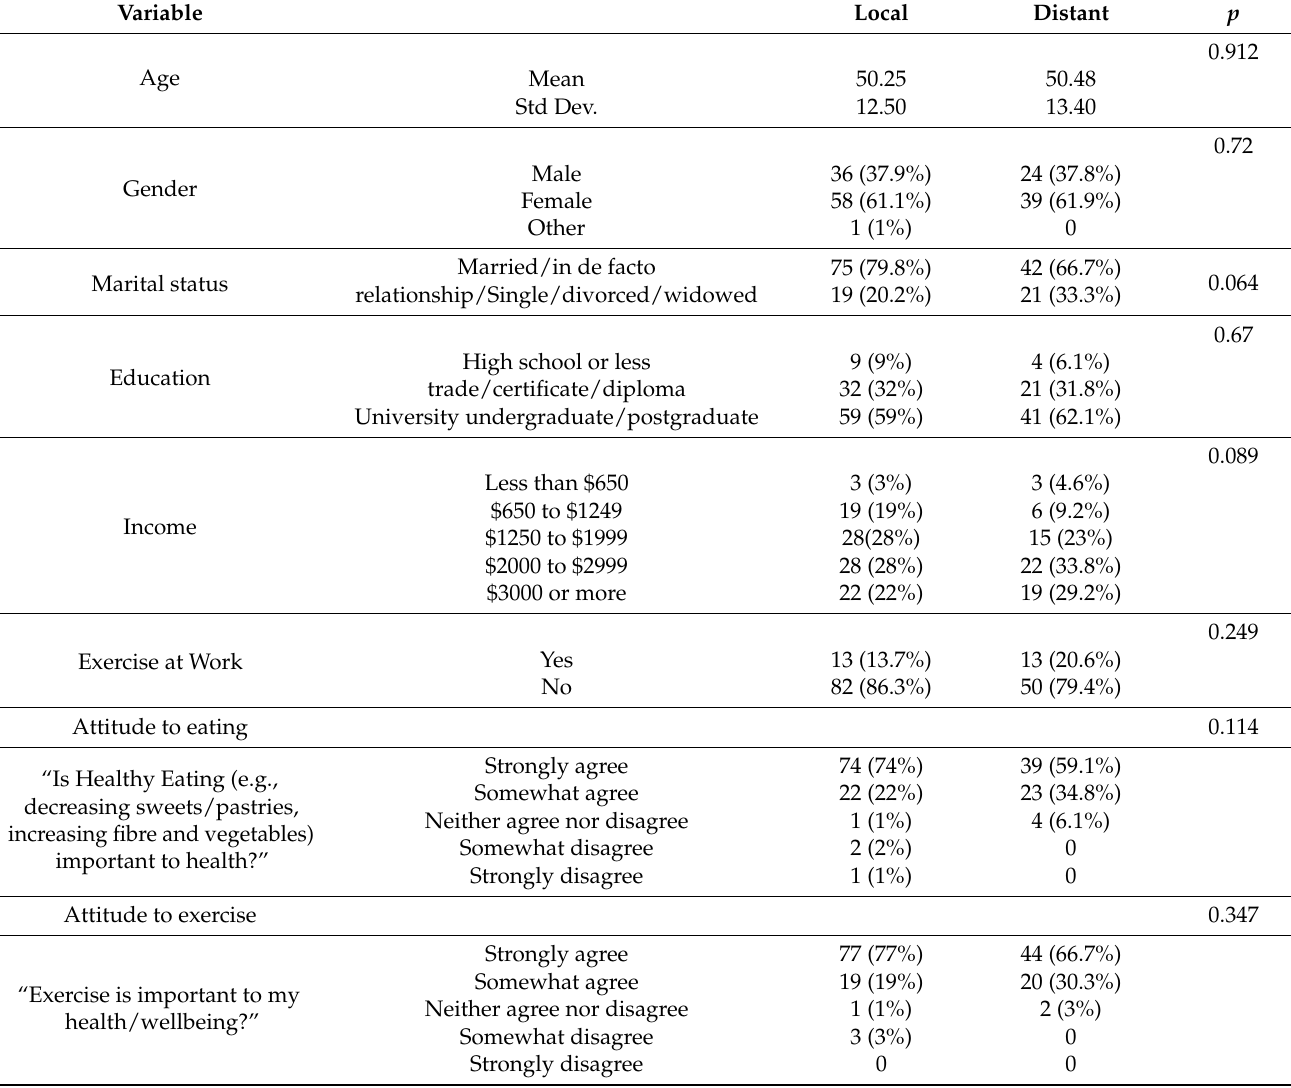
Table 1. Confounding variables to the association between obesity and